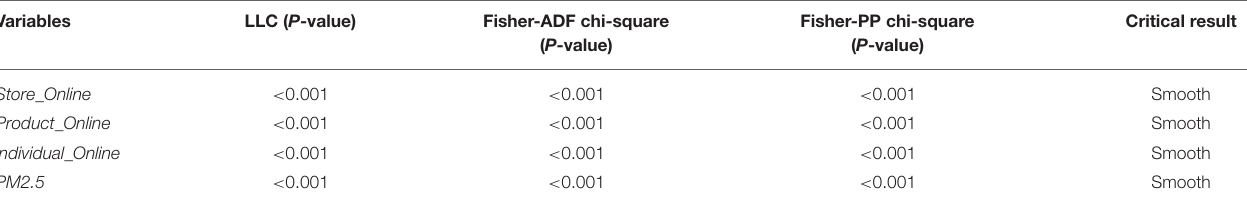
TABLE 3 | Stationarity test of key variables.